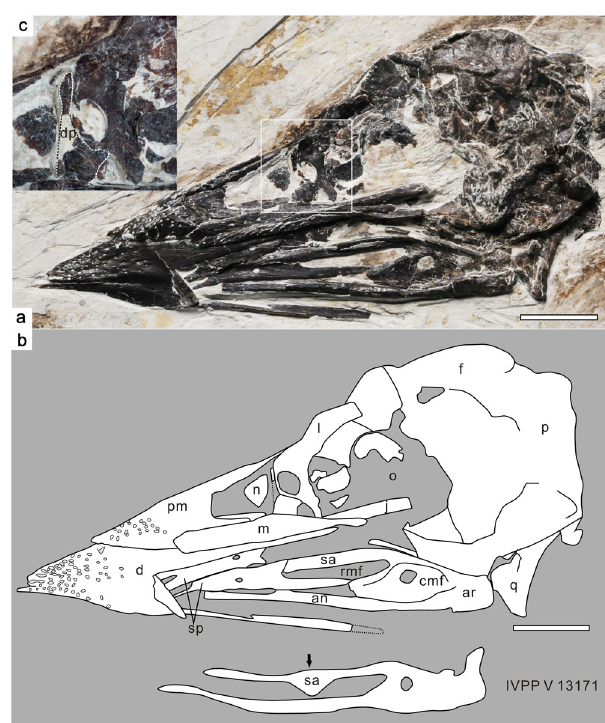
Fig. 3 Skull and mandible of Confuciusornis shifan holotype (PMoL- AB00178). a Photograph. b Schematic line drawing. c close-up of the anterior margin of the orbit. an angular, ar articular, cmf caudal mandibular fenestra, d dentary, dp dorsal process of maxilla, f frontal, j jugal, l lacrimal, m maxilla, n nasal, o orbit, p parietal, pm premaxilla, q quadrate, rmf rostral mandibular fenestra, sa surangular, sp splenial. White rectangle in a indicates the region shown in c . A line drawing of the posterior half of the mandible of Confuciusornis sanctus IVPP V 13171 (drafted based on Fig. 1b in Wang et al. 5 ) is presented below the line drawing of the skull and mandible of Confuciusornis shifan ; arrow indicates the ventral process of the surangular. Scale bars: 1 cm; note that c is not to